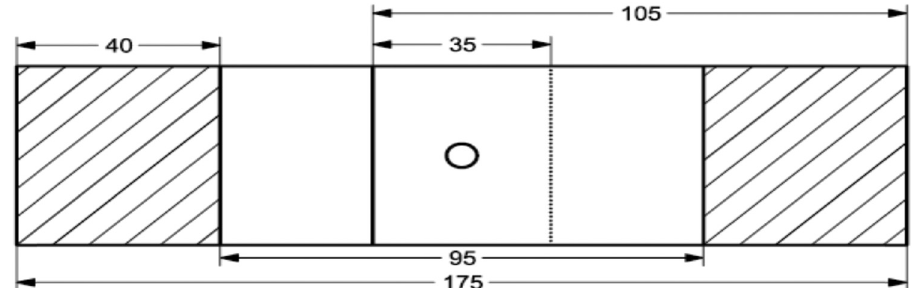
Figure 1: Tensile shear specimen as per AWS D8.9:2012